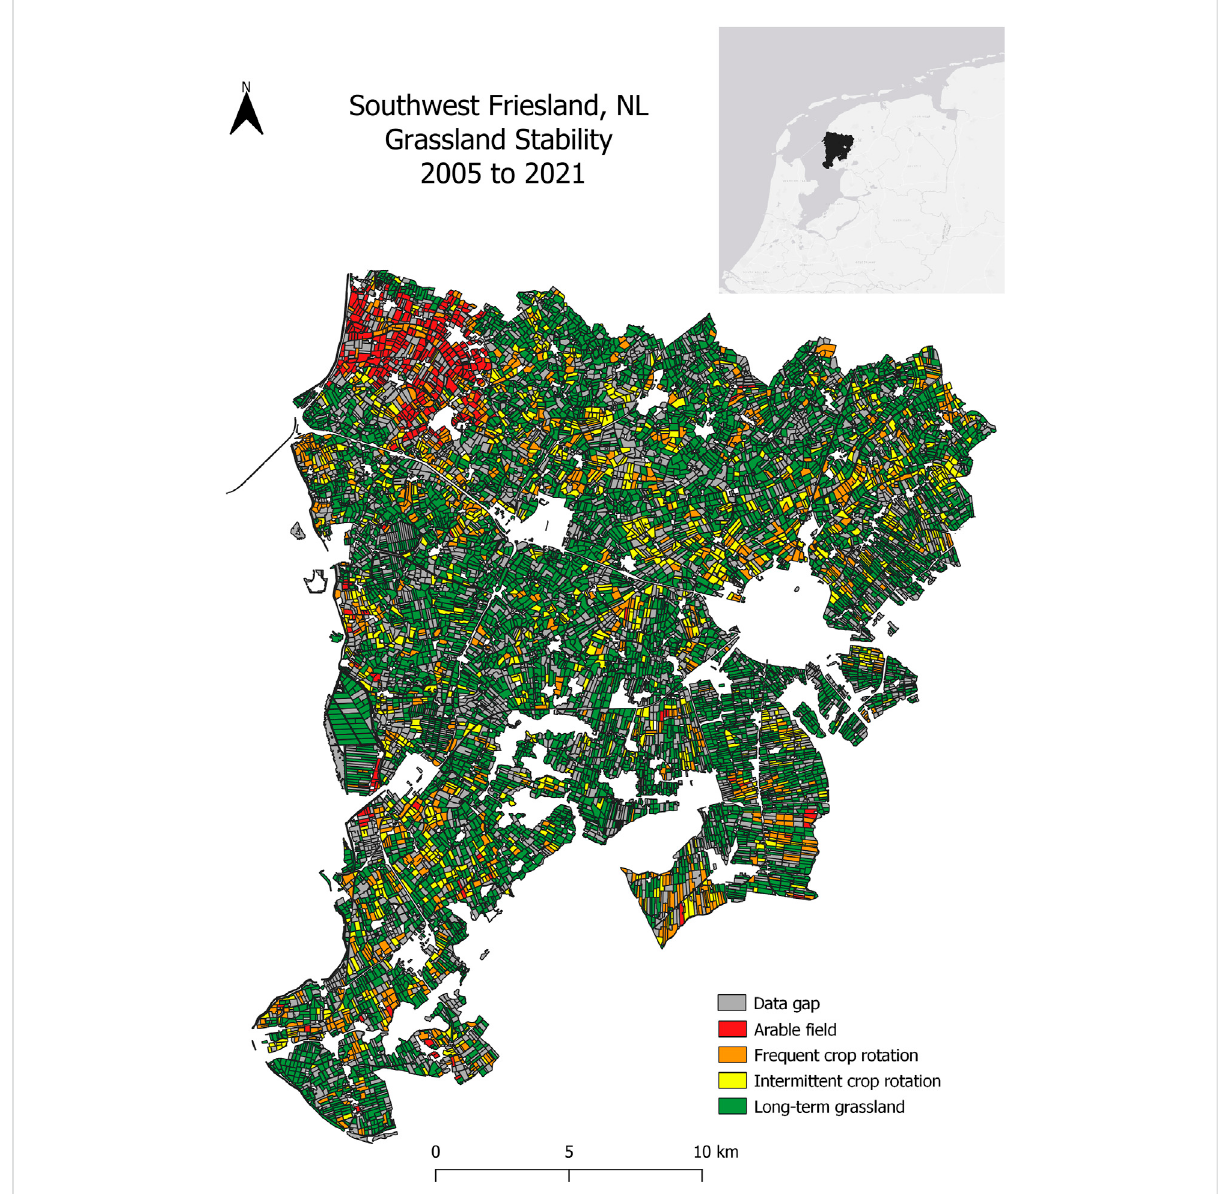
FIGURE 2 Grassland stability map described by the frequency of grassland-to-cropland conversions from 2005 – 2021 in southwest Friesland, NL. Gray parcels indicate the absence of crop registrations in at least 1 year. Other parcels are colored by their number of records as long-term grassland between 2005 and 2021: Arable fi elds = no records; Frequent crop rotation = 1 – 5 years; Intermittent crop rotation = 6 – 16 years; Long-term grassland = 17 years (full duration of study